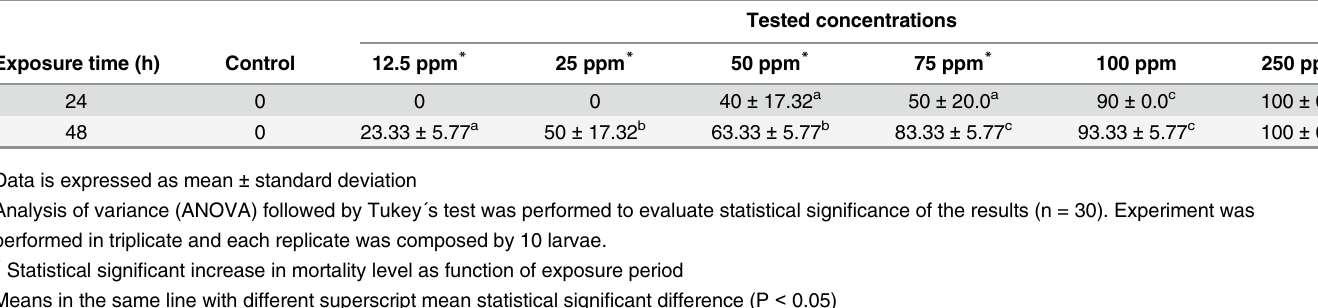
Table 2. Mortality levels (%) of Aedes aegypti larvae after treatment with optimized P . emarginatus nanoemulsion (expressed as P . emarginatus oil content in aqueous media).